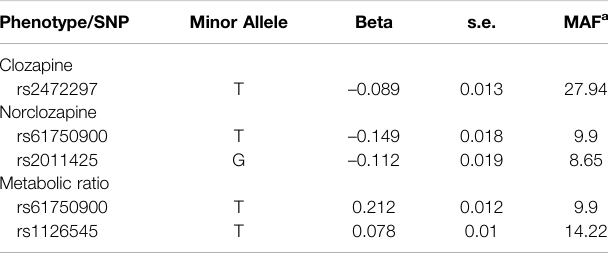
TABLE 1 | Pharmacogenomic SNPs used in the regression analyses, and their association to clozapine metabolite concentrations in the GWAS from Pardiñas et al. (2019).